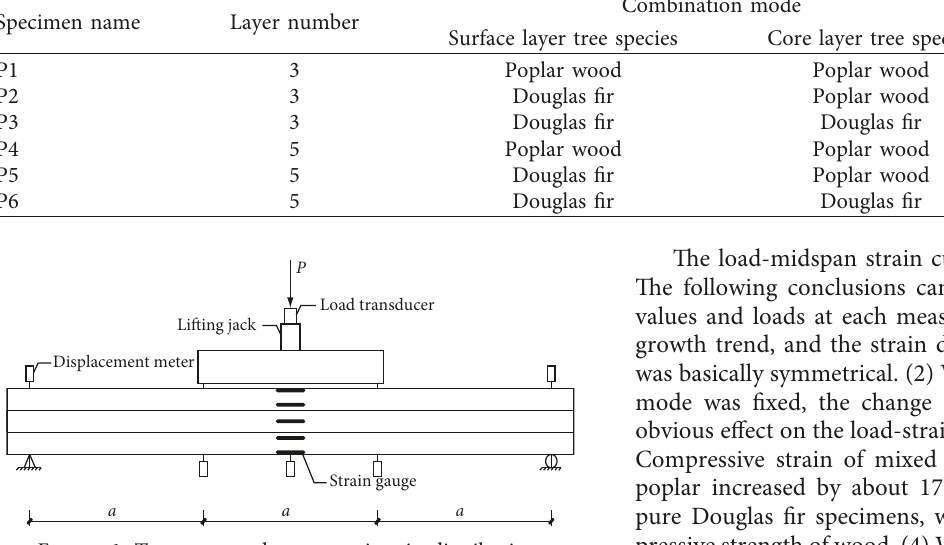
Figure 1: Test setup and survey points in distribution. Table 2: Material properties of